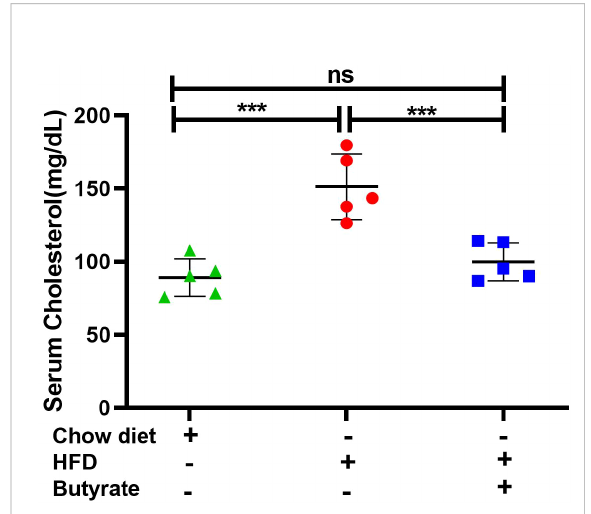
FIGURE 1 Effect of butyrate treatment on serum cholesterol level of HFD (high-fat diet) fed mice (HFD mice). Female mice (10 in number) were fed with HFD for 30 days and then divided randomly into two groups equally. One group continued receiving HFD (HFD mice) and another group received 5% sodium butyrate (butyrate) supplemented with HFD (w/w) for another 15 days (HFD butyrate mice). Another independent group of mice ( fi ve in number) were fed with normal chow diet for 45 days, which served as a control (chow mice). On day 45, serum cholesterol levels in chow mice, HFD mice, and HFD butyrate mice were determined and expressed in mg/dl. N = 5/group; the experiment was repeated thrice. The data are presented as mean ±SE. ns represents not signi fi cant, *** represents p <